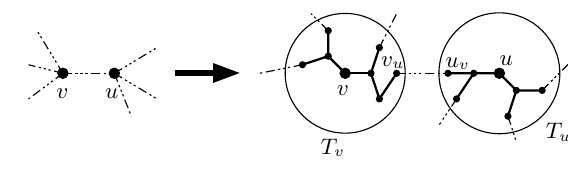
Figure 4: The construction of H from